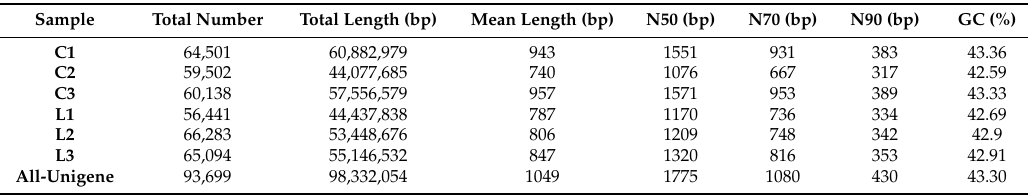
Table 1. Summary of data generated from mandarin fish